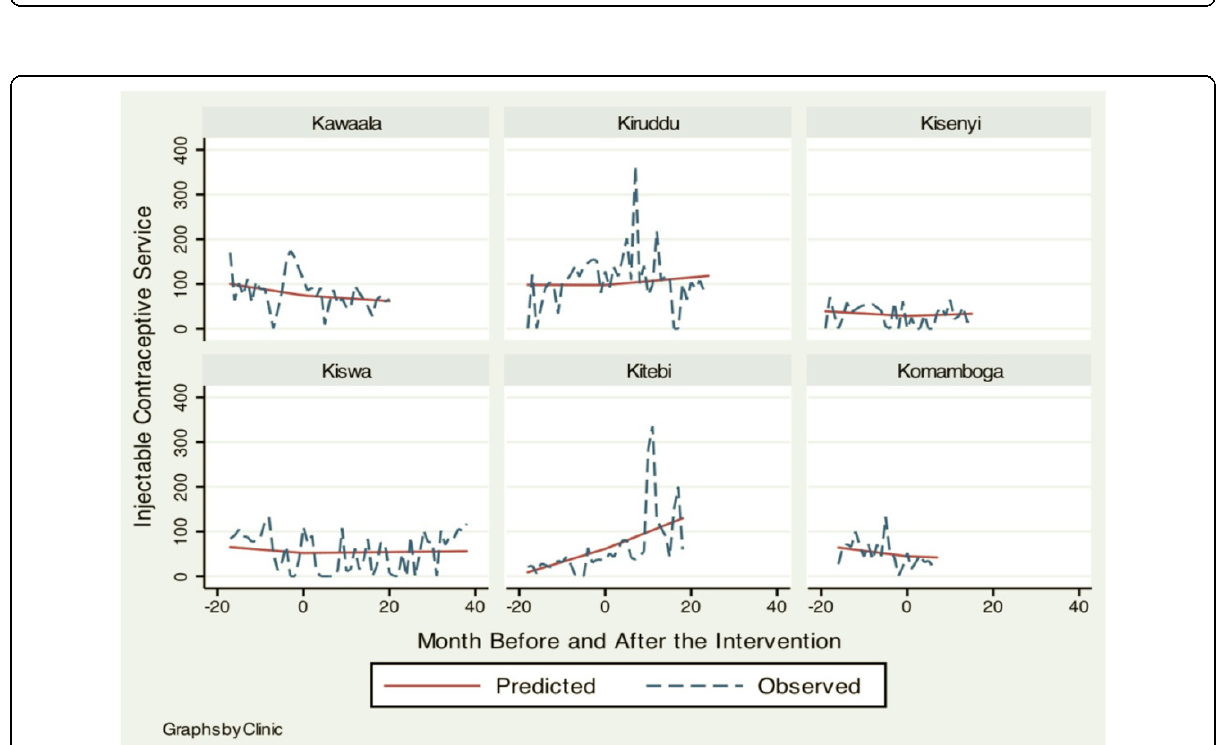
Figure 2 Fitted trends for key health services . Graphs by Clinic.